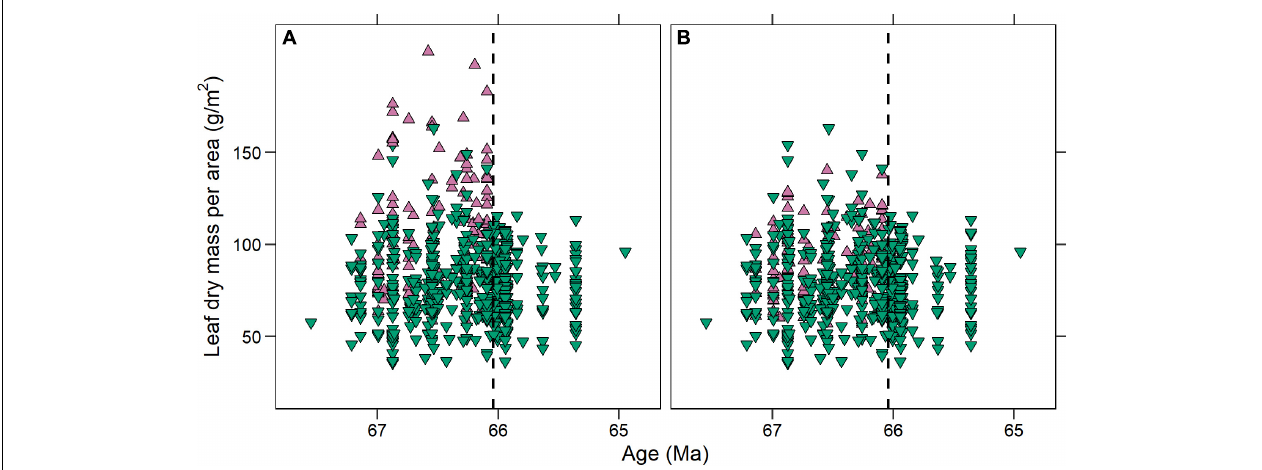
FIGURE 4 | Individual leaf dry mass per area (LMA) estimates for the Williston Basin (A) before and (B) after revision. Upward facing purple triangles represent fossils that we measured again. The convergence in LMA space across the Cretaceous—Paleogene boundary (black dashed line) observed by Blonder et al. (2014) is still apparent after revision, although the loss of high-LMA leaves is less